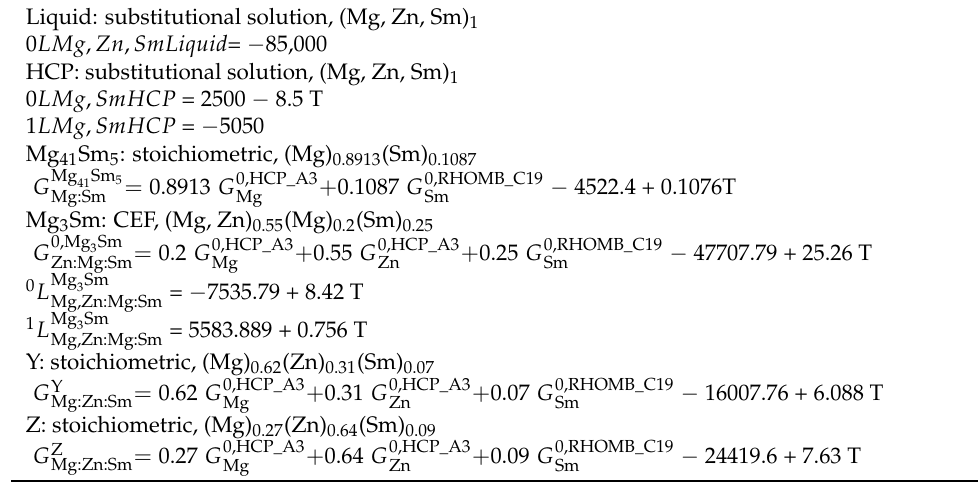
Table 3. Optimized thermodynamic parameters of the Mg-Zn-Sm system in this work. Values are given in SI units and correspond to 1 mol of formula units of the phases.